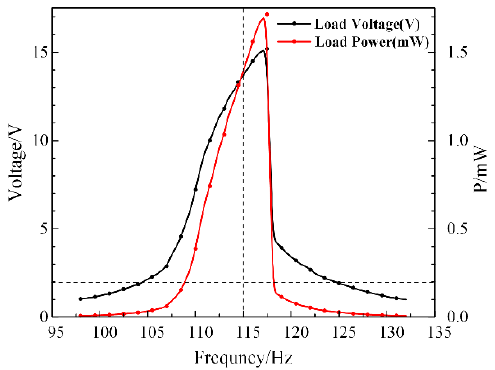
Figure 6. Dependency of the voltage on frequency domain of the